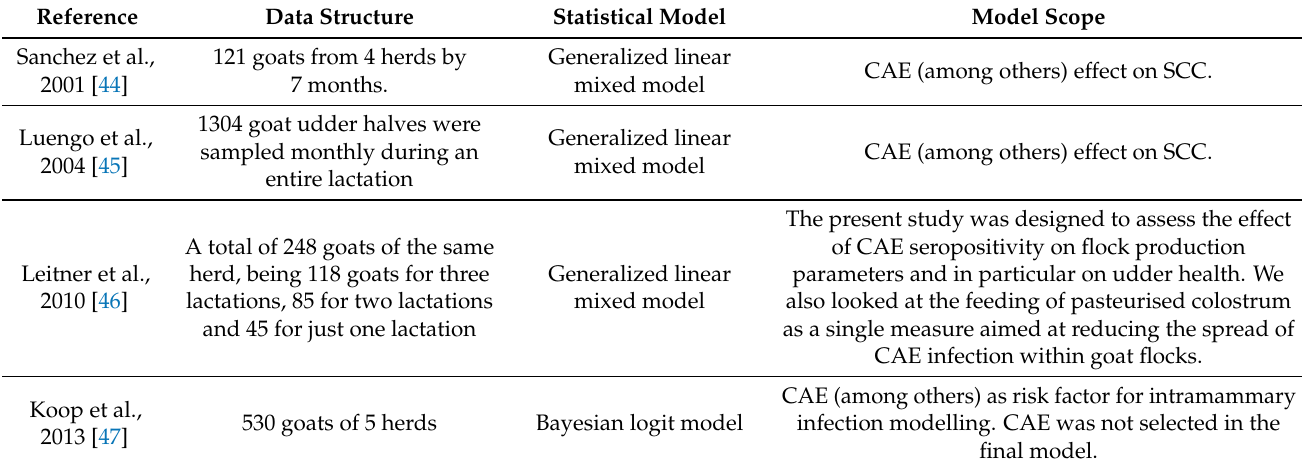
Table 3. Articles that modelled the effects of CAE in the incidence of other